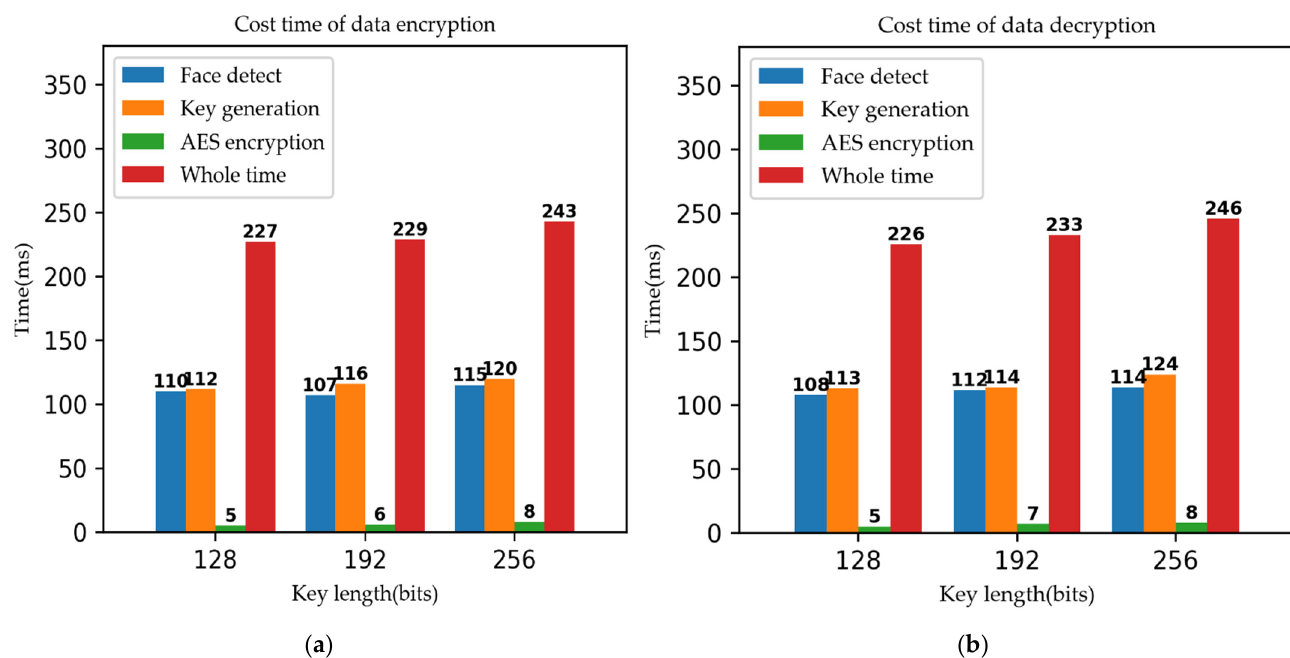
Figure 10. Time cost of data encryption and decryption: ( a ) Time cost of several modules in data encryption process at different key lengths; ( b ) Time cost of several modules in data decryption process at different key lengths.